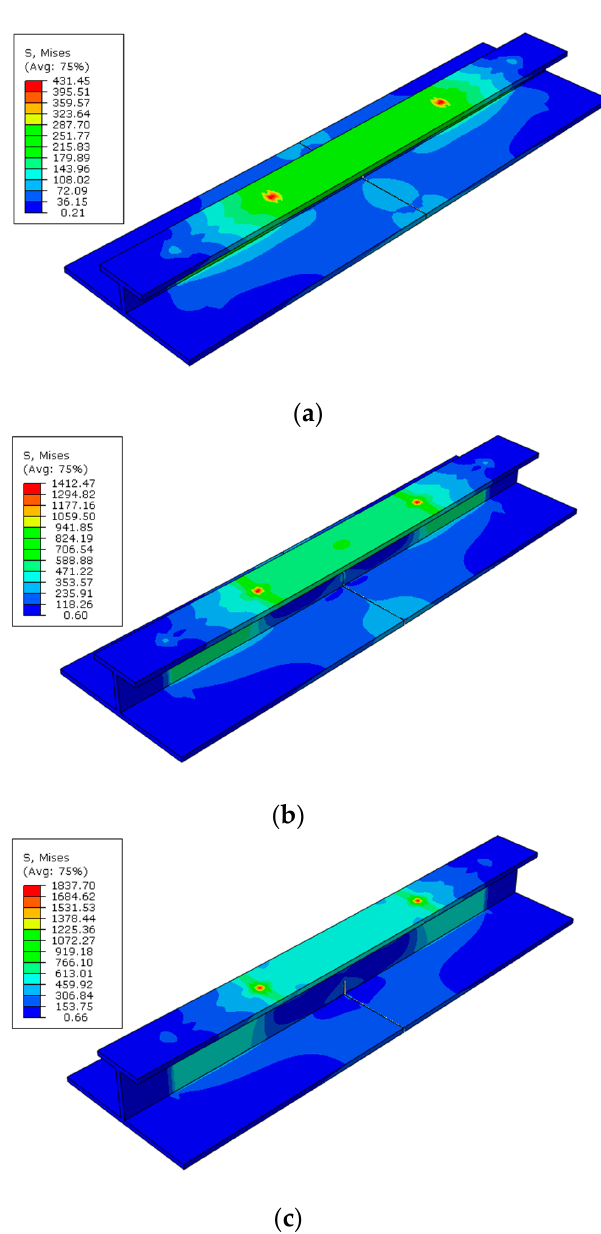
Figure 17. Stress contour plots for bending model in different stiffener sizes; ( a ) h w = 50 mm, RF = 74.4 kN; ( b ) h w = 75 mm, RF = 255.4 kN; ( c ) h w = 100 mm, RF = 335.3 kN. (Unit: MPa.)